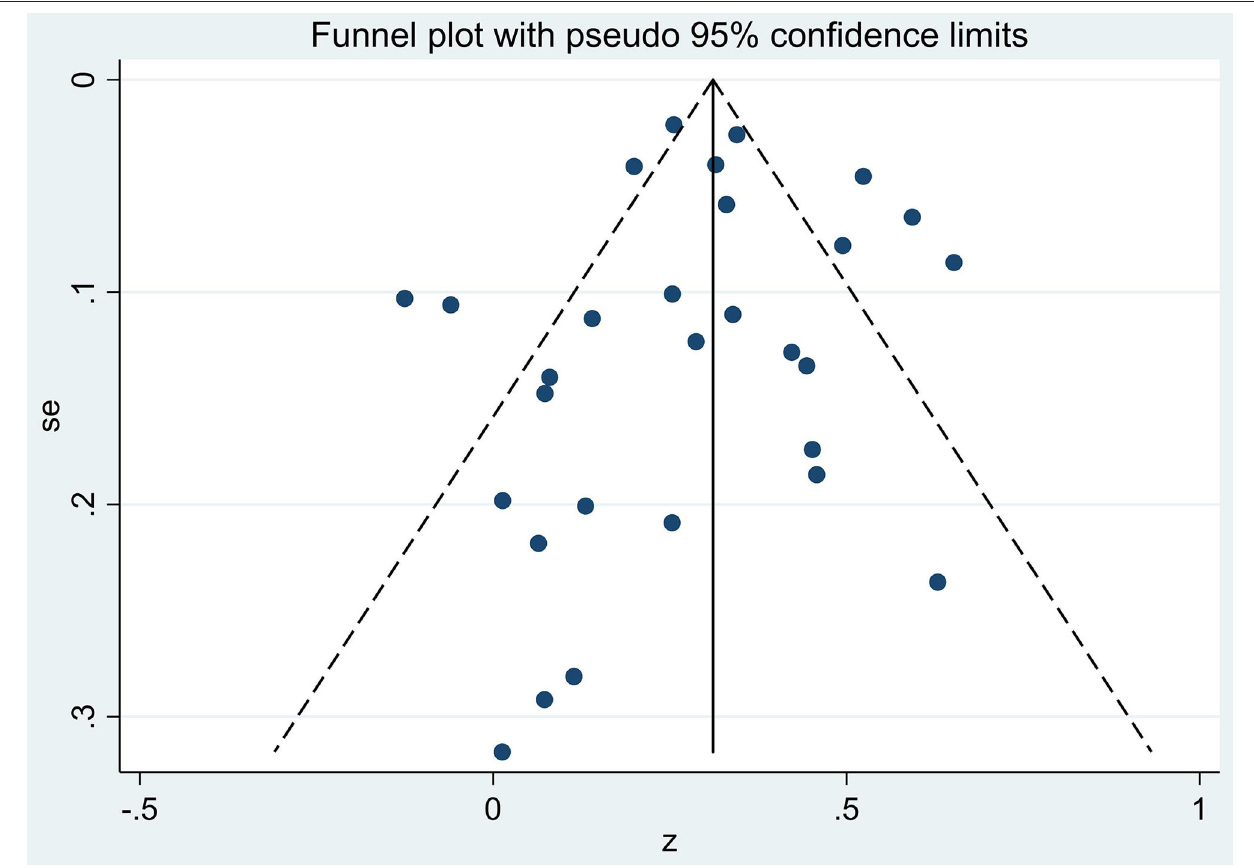
FIGURE 3 | Funnel plot of the four covariates: year of publication, cancer type, age of sample, and FCR measurement on gender by fears of cancer recurrence (FCR) association effect sizes (z).